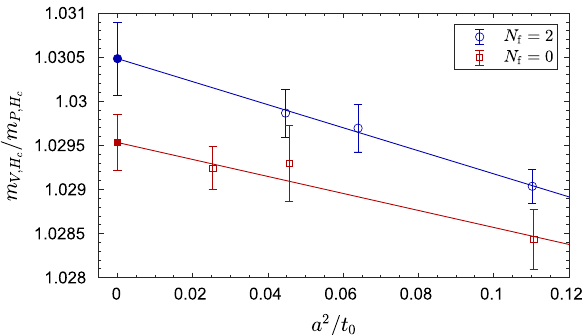
/ m = 2 (blue P , H c for N f c